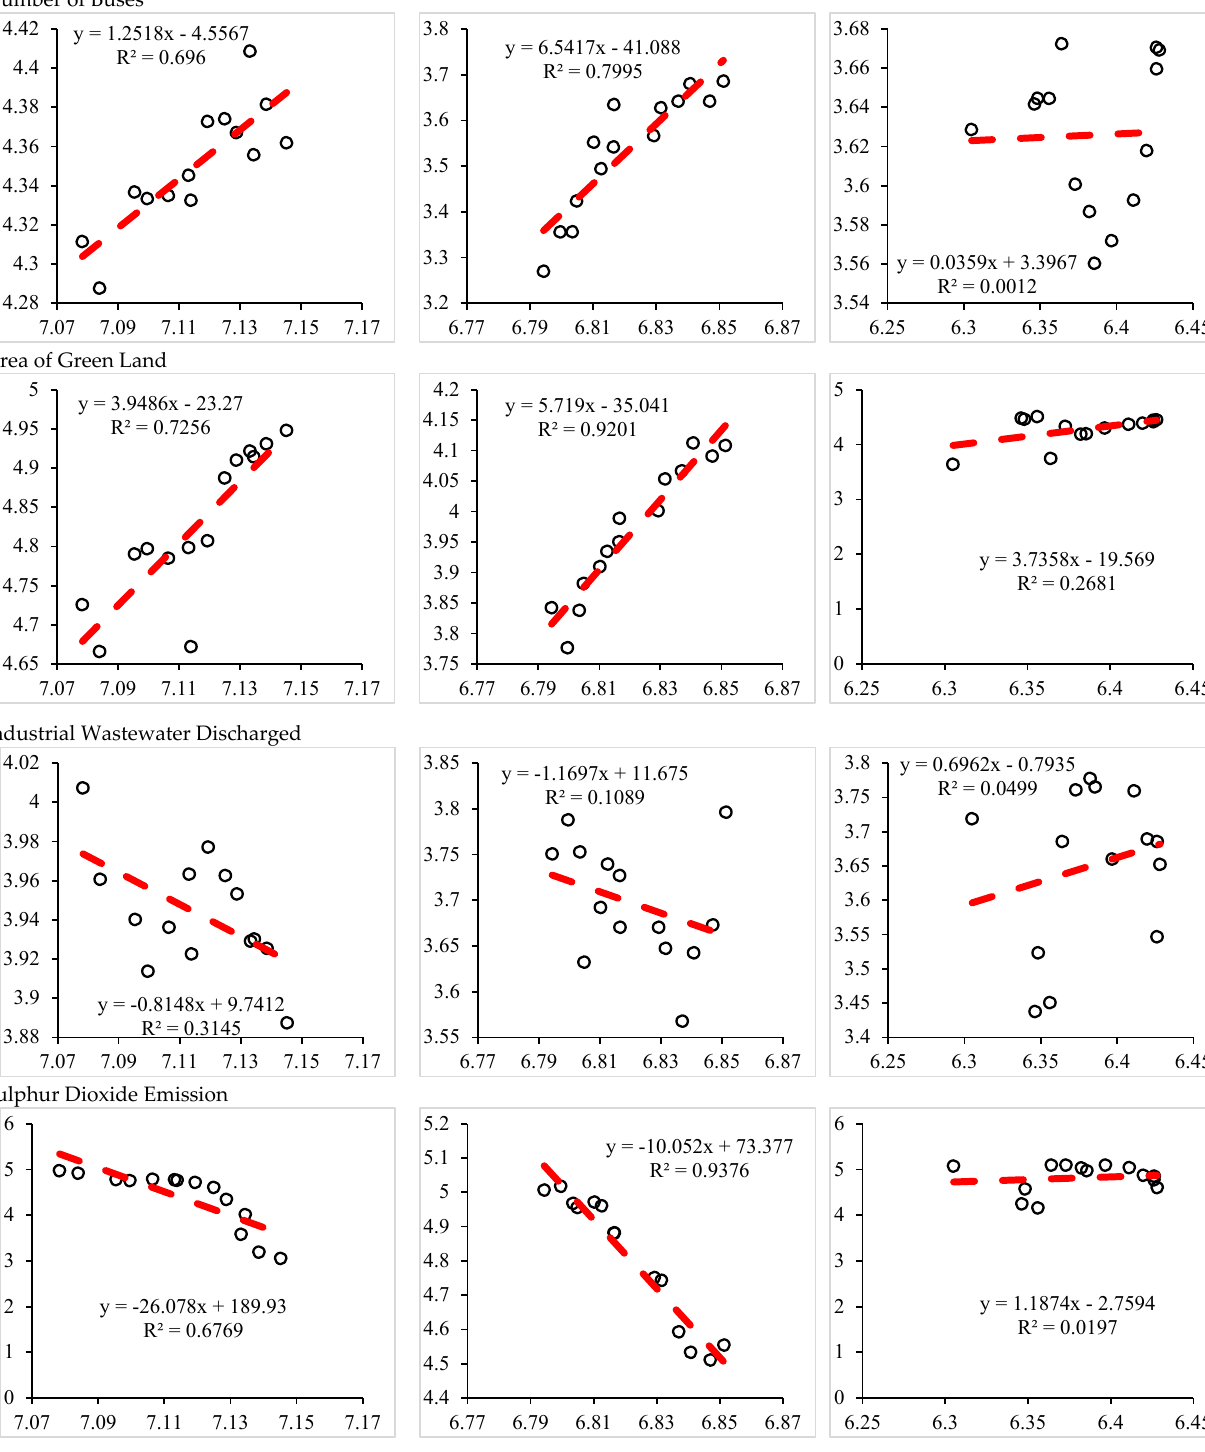
Figure A2. Allometric growth fitting results of urban resilience indicators in Beijing, Fuzhou, and Urumqi from 2006 to 2019. References 1.